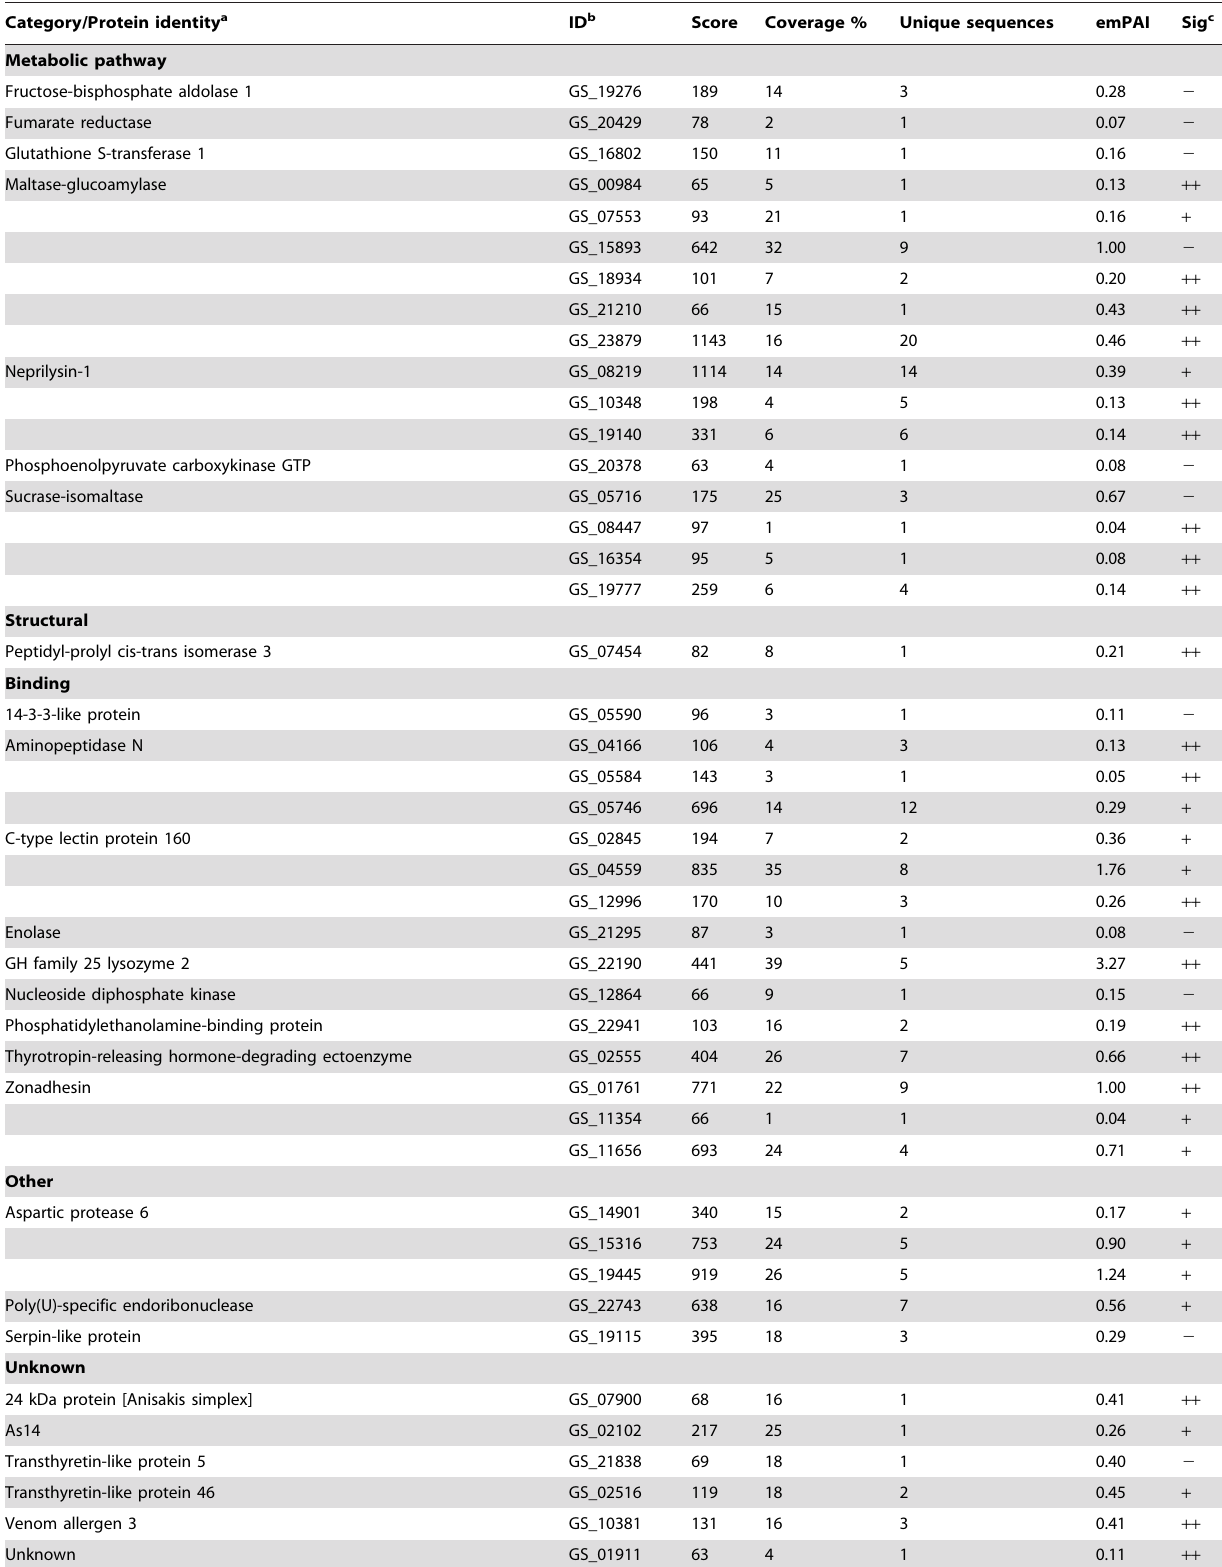
Table 3. Protein identifications in A. suum L4 ES